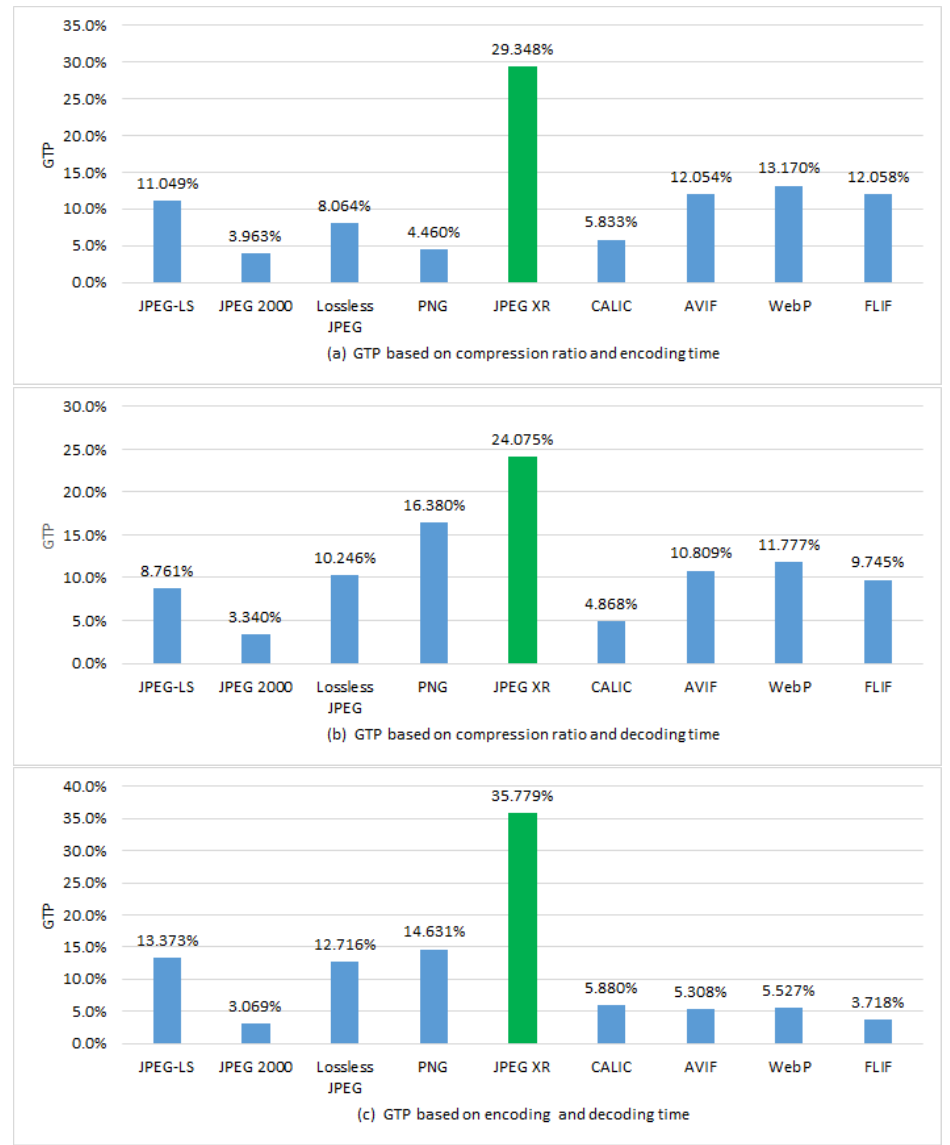
Figure 32. Two-parameter GTP for 16-bit RGB